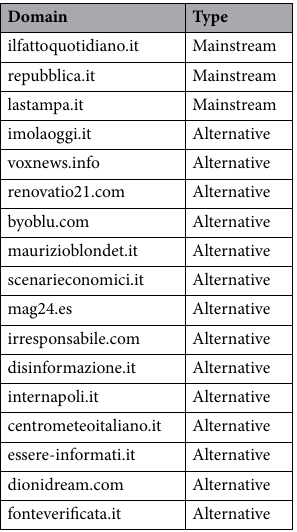
Table 1. List of the media outlets web domains